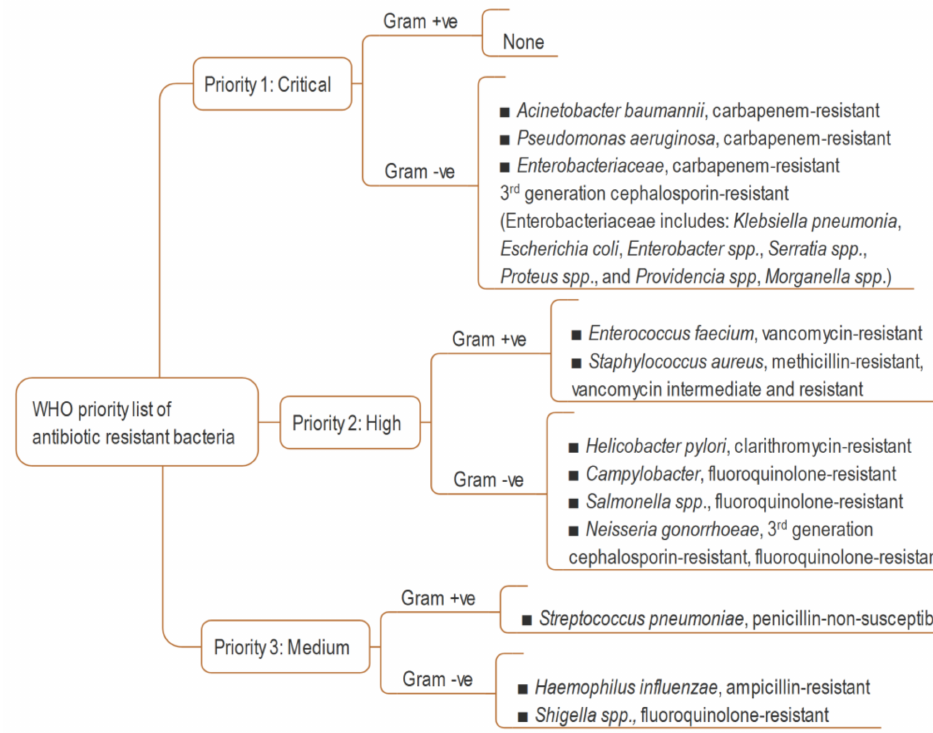
Figure 1. WHO global priority list of resistant bacteria